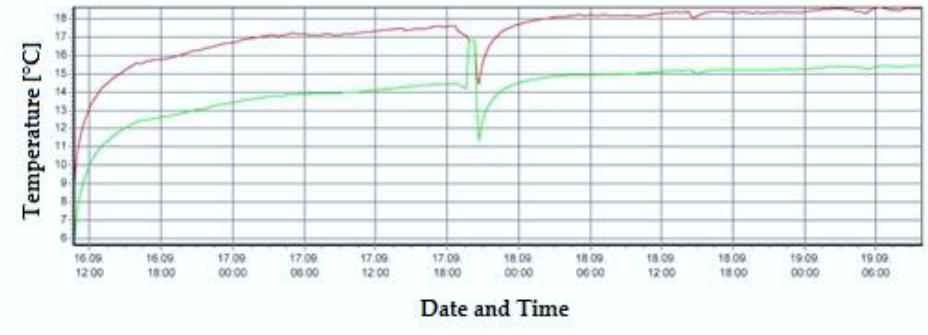
Figure 4. Temperatures achieved during the thermal response test [9,16].